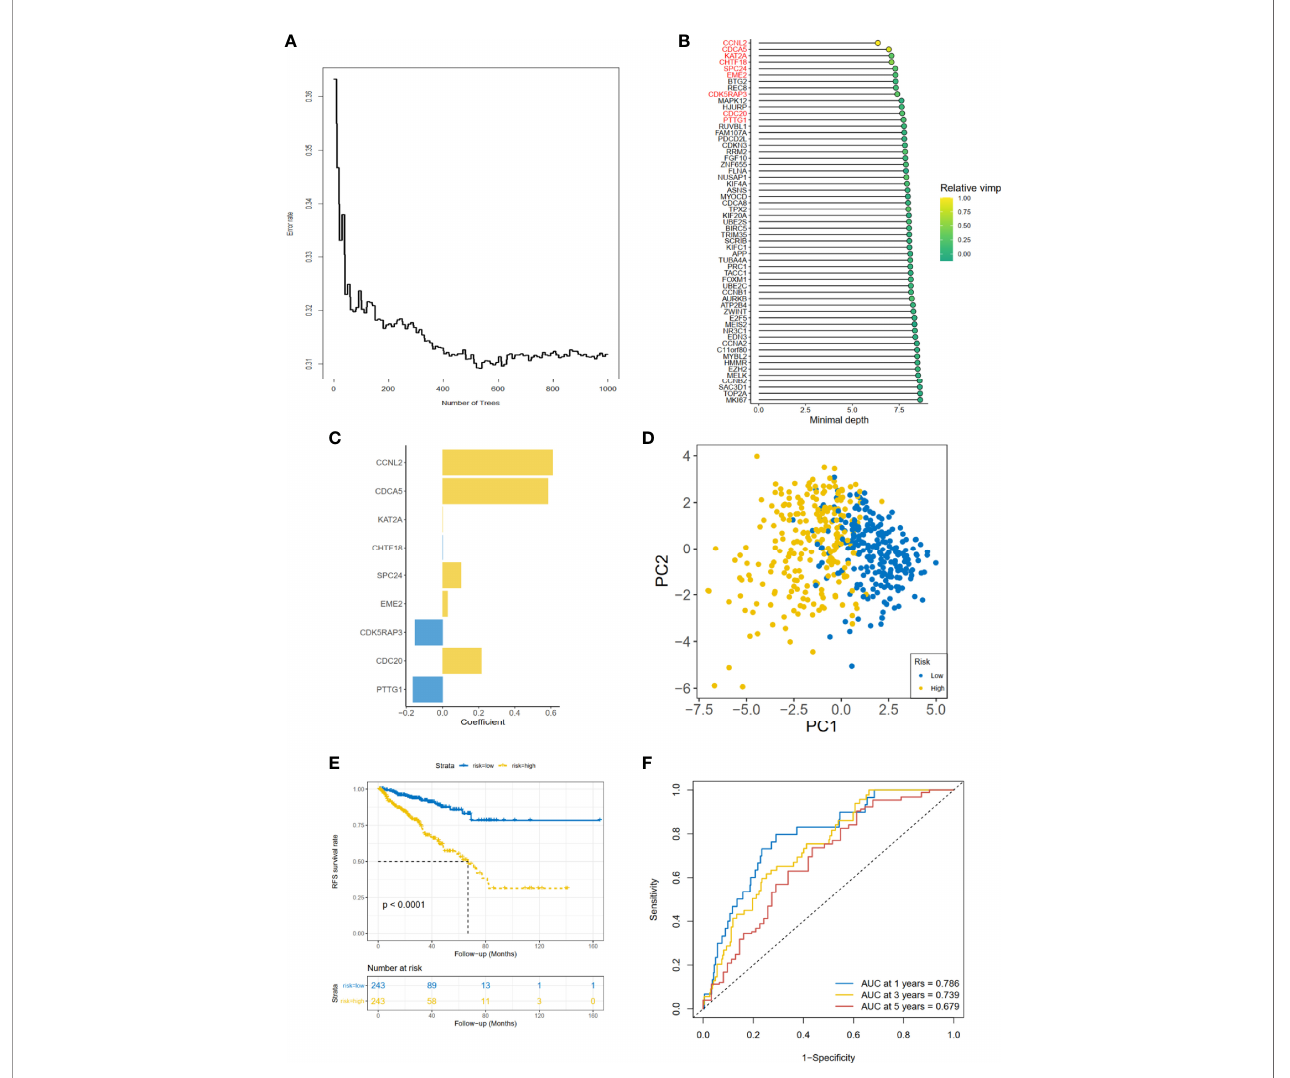
FIGURE 2 | Gene selection and risk prognostic model of CCRGs based on TCGA cohort. (A) Estimation of the OOB prediction error rate based on the random forest. (B) The top 15 genes according to both minimal depth and variable importance. (C) The coef fi cient for genes of risk prognostic model. (D) The distribution of risk scores based on PCA. The high-risk group was annotated by yellow and the low-risk group by blue. (E) Kaplan – Meier curves of RFS strati fi ed by risk score. (F) Time-dependent ROC curve analysis for risk score. CCRGs, cell cycle-related genes; TCGA, The Cancer Genome Atlas; OOB, out of bag; PCA, principal component analysis; RFS, recurrence-free survival; ROC, receiver operating